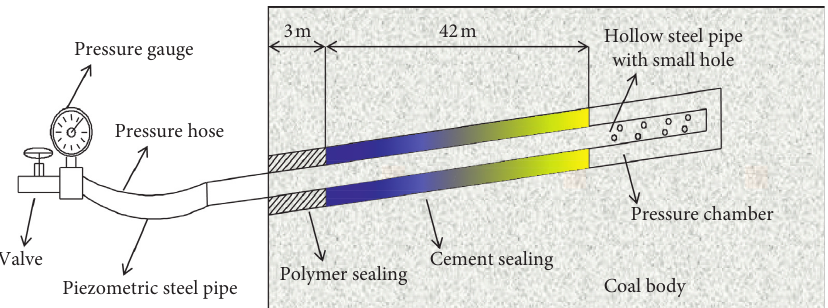
Figure 6: Schematic diagram of pressure hole